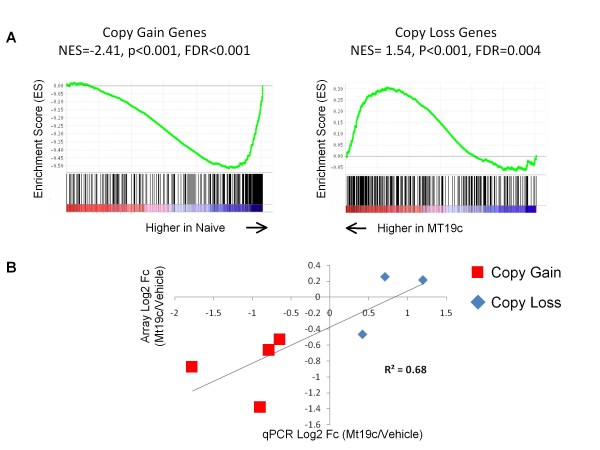
Genes in copy number gain or loss regions mediate gene expression and are significantly affected by MT19c treatment. A. GSEA Enrichment plots suggest that amplified genes are significantly down-regulated by MT19c compared to naïve tumors while copy number loss genes are significantly up-regulated by MT19c. Significantly amplified (log ratio > 0.3) or deleted genes (log ratio < -0.3) with concomitant high or low expression were selected to define the gene sets. The black lines demonstrate where each gene in the gene set falls within the 15,000 probe sets probing RefSeq transcripts ordered from left to right based on the expression level in MT19c treated or naïve tumors with gene #1 the most highly expressed in MT19c treated tumors. The green line represents the running ES score that becomes more negative as probe sets are identified toward the bottom of the list. More black lines are observed near the top of the rankings in untreated tumors (right side) than in the treated tumors (left side) for amplified genes while genes in LOH regions are biased towards treated tumors (right side). The genes that are most significantly affected by MT19c may be the most important genes mediating SKOV-3 tumor growth and survival. B. qPCR of selected genes within CNAs validates microarray observations. Copy loss genes include PBEF1, STEAP1, and ZNF32. Copy gain genes are PNMT, GRN, PAPLN, and SLC25A6.